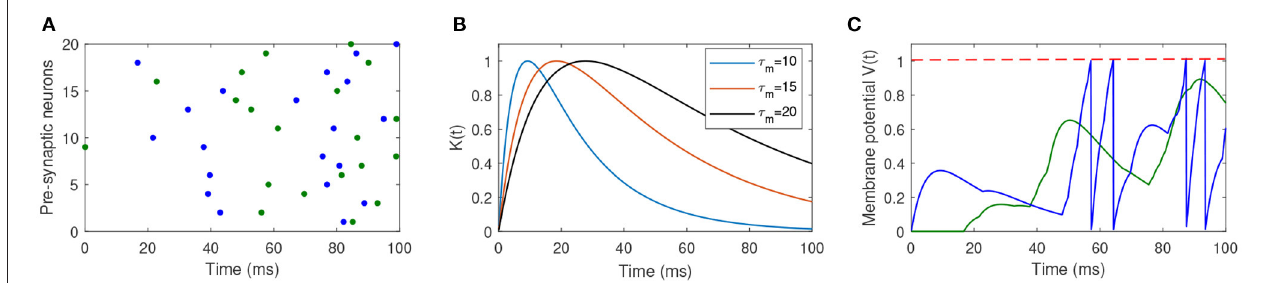
FIGURE 1 | Illustration of the dynamics of the used spiking neuron. (A) Two different input spike patterns, which are distinguished by different colors. (B) The shape of the PSP with different values of τ m and τ s . (C) The membrane potential of the postsynaptic neuron in response to different input spike patterns. The blue input spike pattern makes the postsynaptic neuron fire four spikes, while the green input spike cannot make the neuron fire a